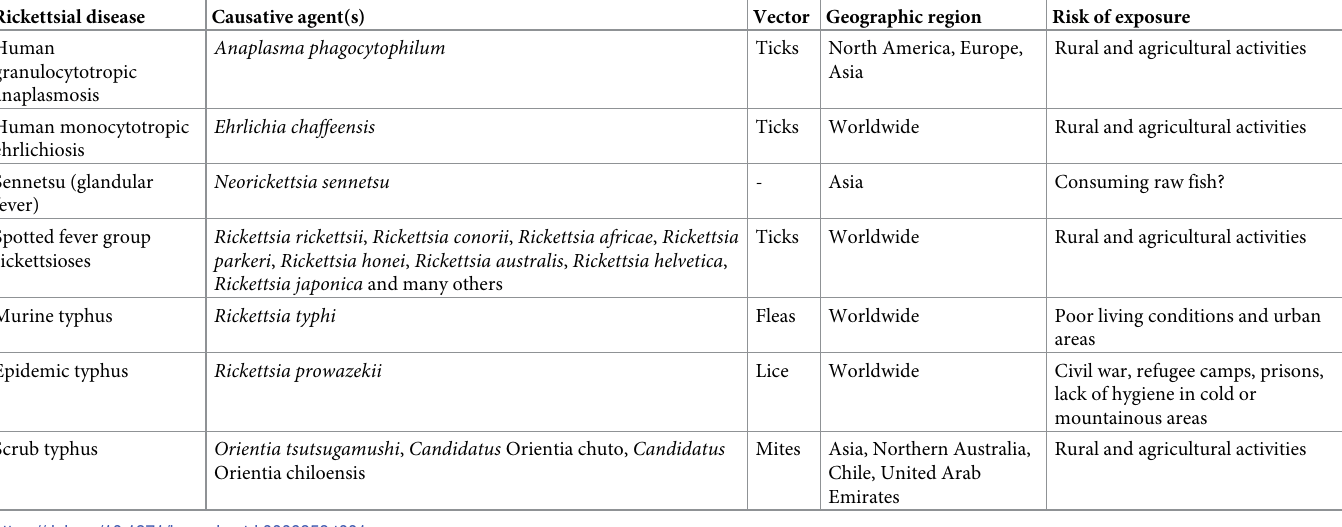
Table 1. An overview of rickettsial diseases, their vectors, and their known regions of endemicity. Rickettsial